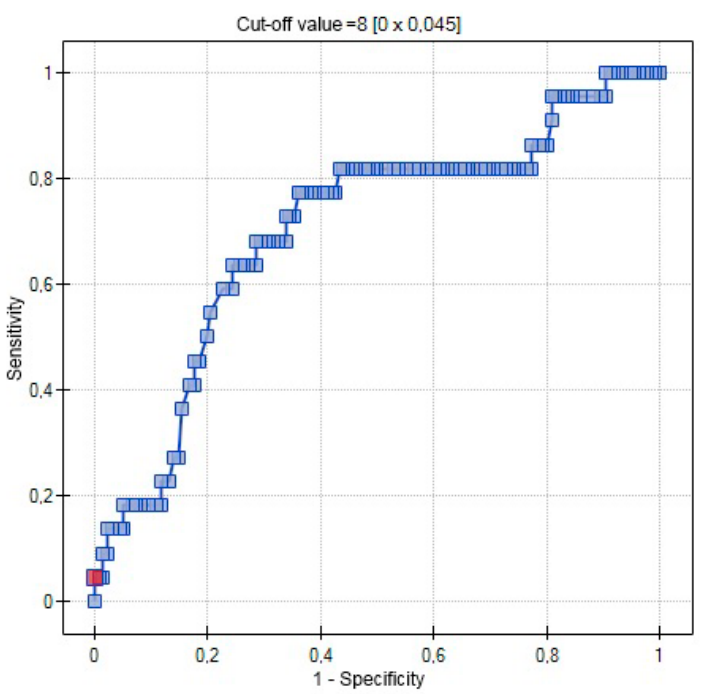
Figure 2. ROC curve-relationship between 25(OH)D concentrations (ng/mL) and occurrence of preeclampsia (AUC 0.7029), (red point—cut-off value)